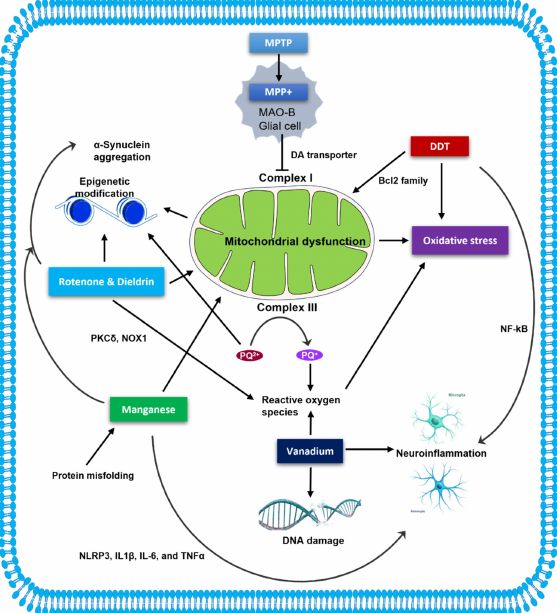
Figure 1. Cellular stress signaling in neurotoxicant ‐ induced neuronal degeneration. Mitochondrial dysfunction is a central driver of PD and plays a significant role in PD pathogenesis. In the brain, MPTP is first metabolized to MPP by the enzyme MAO ‐ B in glial cells. Upon uptake via DA trans ‐